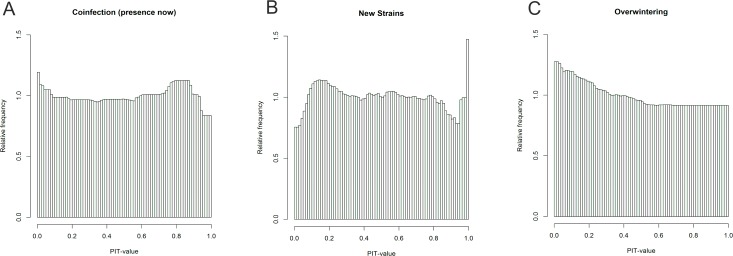
PIT-value distributions.The close-to-uniform distributions of the corrected PIT-value for the coinfection (A), new strain emergence (B) and overwintering (C) indicate adequacy of the models.